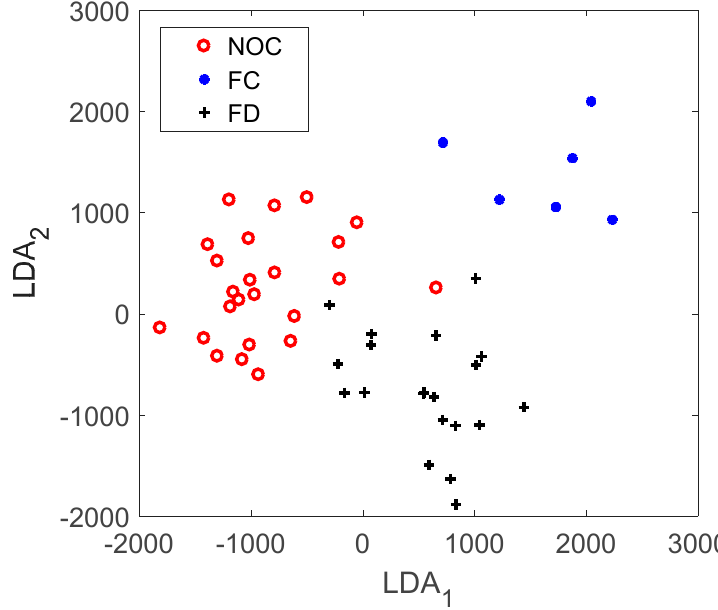
Figure 14. Visualization of the texton feature set of the mill load data (Case Study 1) as projected onto 2D space using linear discriminant scores, LDA 1 and LDA 2 .